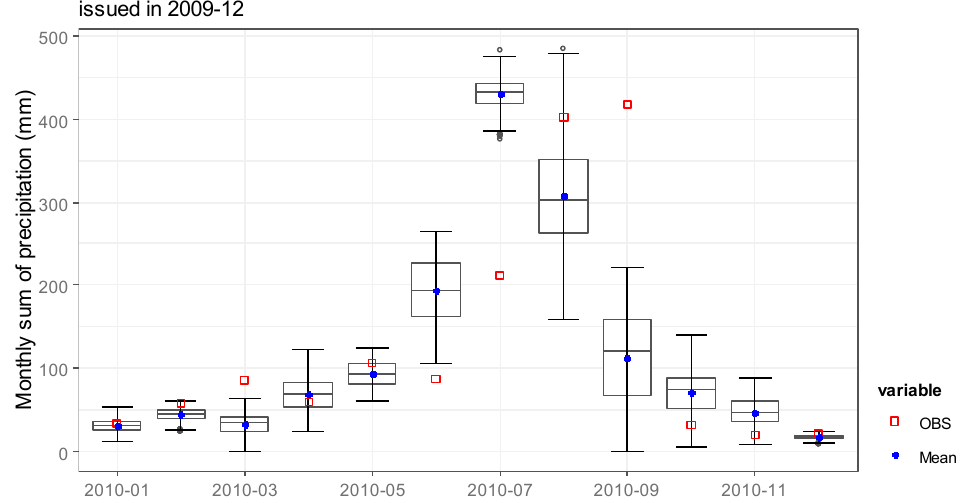
Figure 9. Results of monthly precipitation forecasting from January to December 2010.